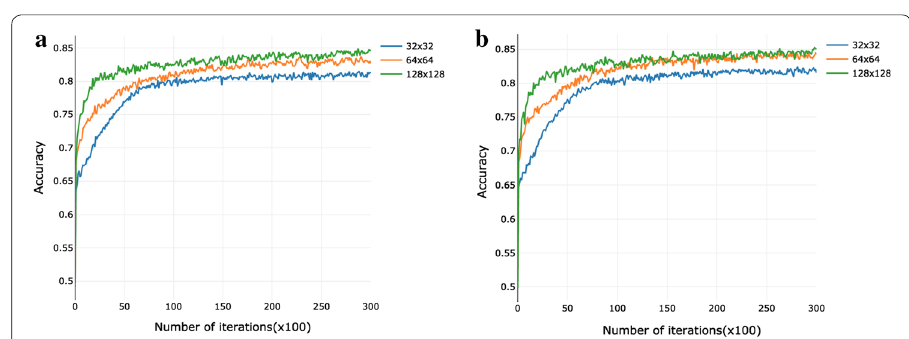
Fig. 7 Accuracy curves. a Averaged accuracy versus the number of iterations for the full‑set. b Averaged accuracy versus the number of iterations for the